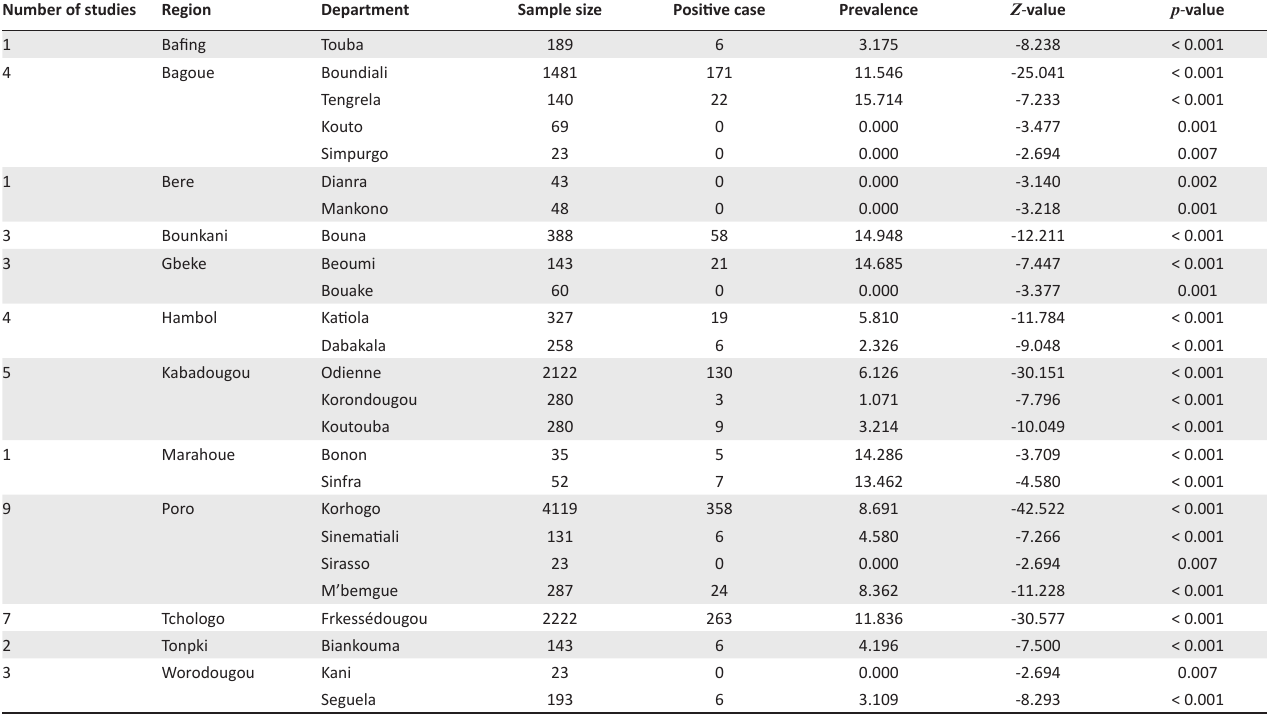
TABLE 1-A1: Pooled prevalence estimates of bovine trypanosomiasis by region and department. Number of studies